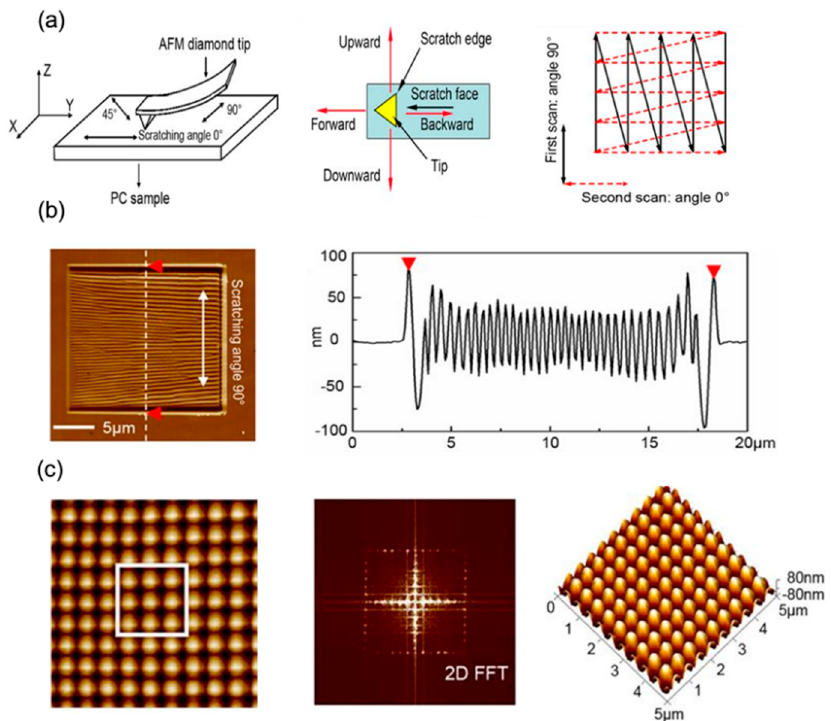
Figure 3. Schematic diagram of the formation process of nanodot arrays: ( a ) trajectory of the tip when making a two-step scanning at 90°. ( b ) the 2D image of bundles after the first-step scanning and its cross-section. ( c ) 2D/fast Fourier transform (FFT)/3D image of nanodot arrays when scratching at 90° and 0° [80] .